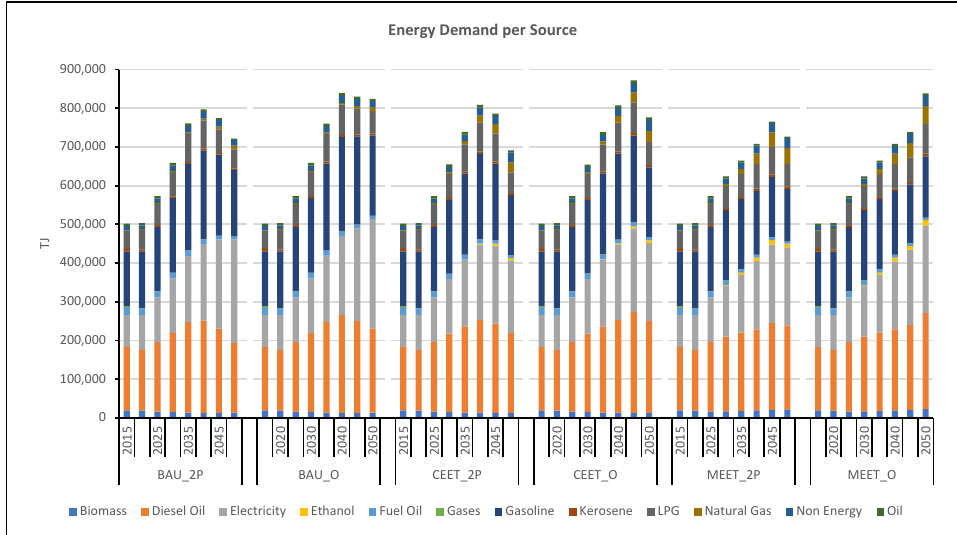
Figure 7. Evolution of energy demand per source and scenario.